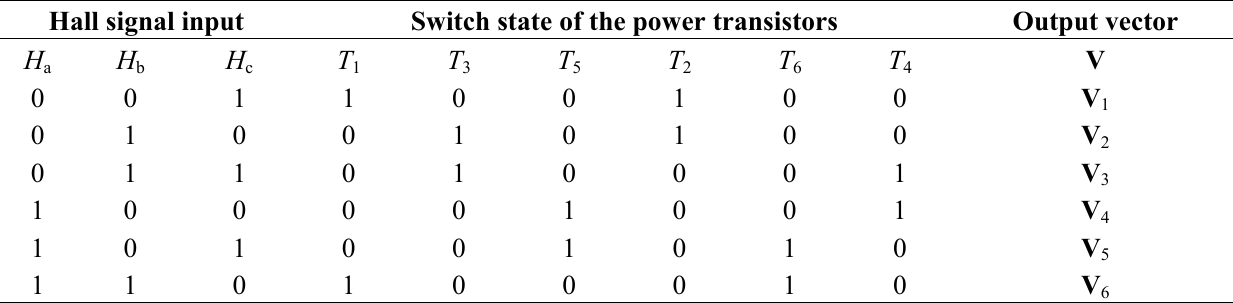
Table 1. Switch table of the power converter in which two power transistors conduct at the same time in each sector.